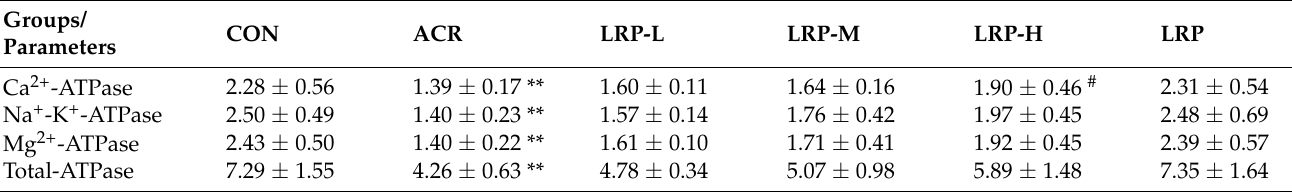
Table 2. The Effect of LRP on the level of ATPase activities in liver